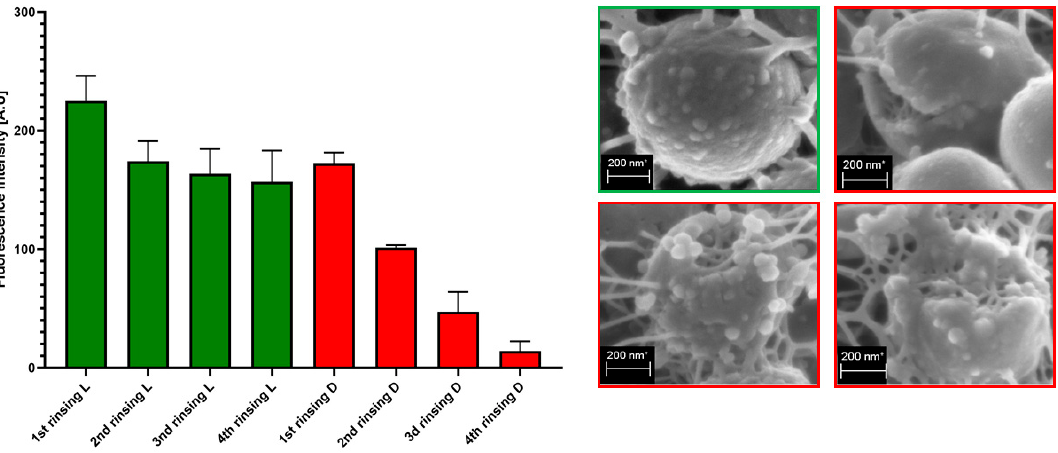
Figure 7. The impact of subsequent rinsing steps on fluorescence intensity of SYTO-9 (L) and PI-dyed (D) biofilm-forming cells of the ATCC6538 strain. The right panel shows staphylococcal cells of an intact cellular wall (green frame) and staphylococcal cells of an increasing level of cell wall damage (red frames) in result of rinsing. The scale bar is 200 nm. Magnification 100,000×, Microscope Auriga 60.